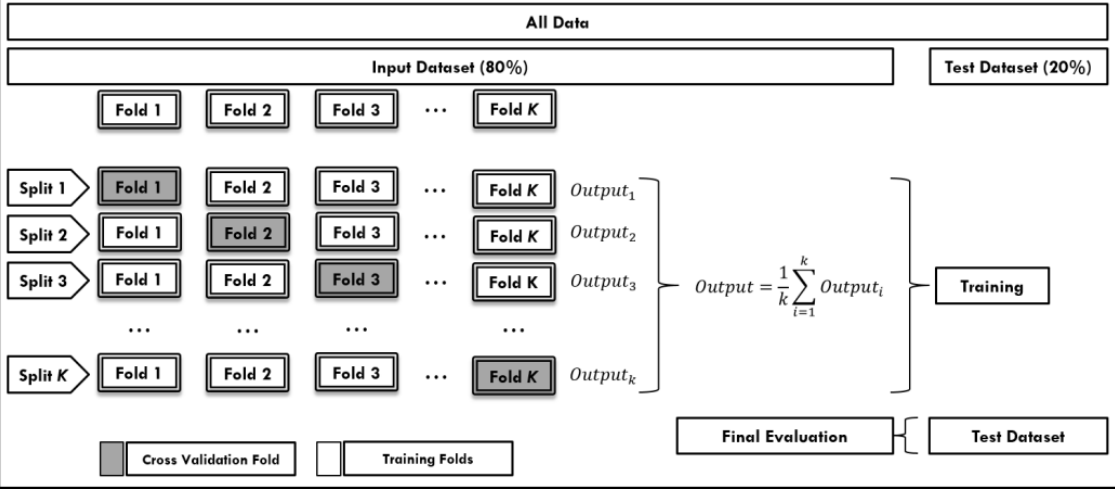
Figure 3. K-Fold Cross-Validation.